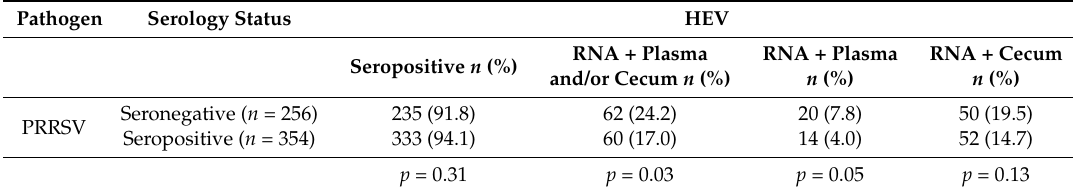
Table 2. Association of hepatitis E virus (HEV) with porcine reproductive and respiratory syndrome virus (PRRSV) seropositivity (from 610 plasma samples where both tests were performed). Pathogen